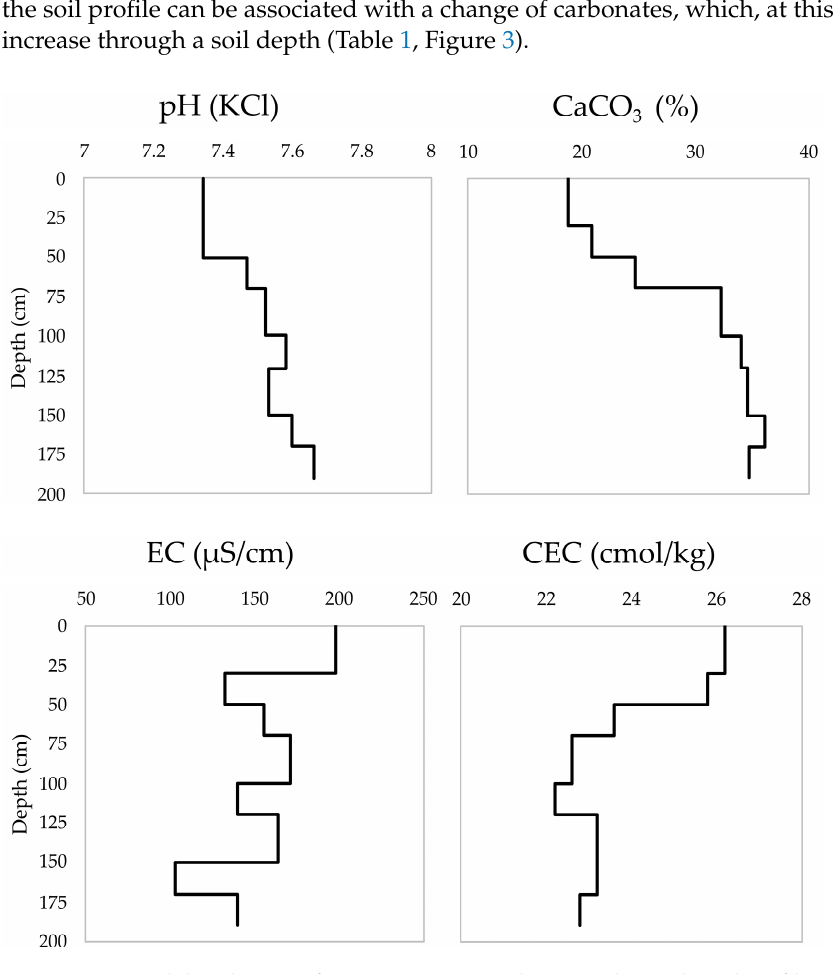
Figure 3. Vertical distribution of pH, EC, CaCO 3 and CEC in the study soil profile. Table 1. Physical and chemical characteristics of analyzed soils.